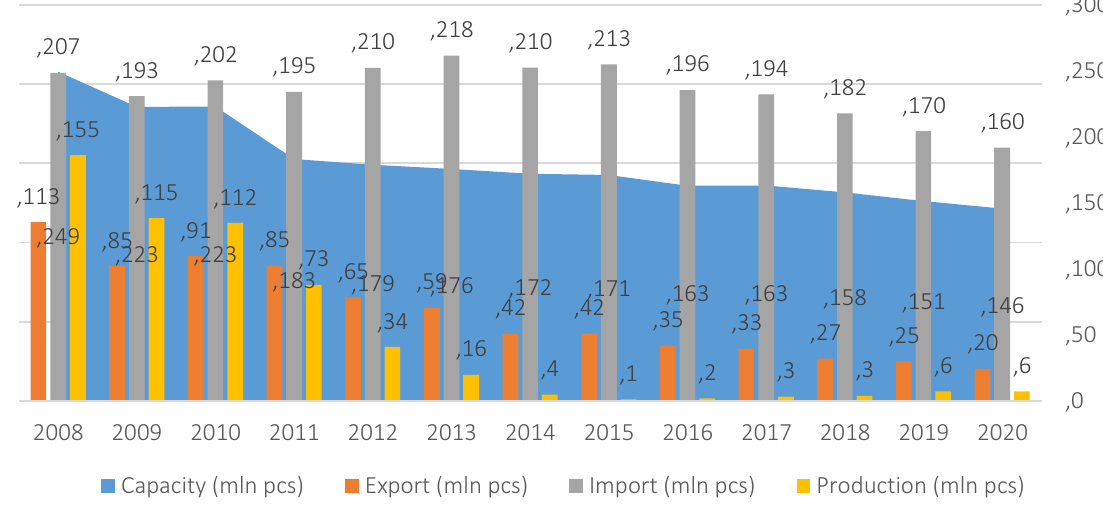
Figure 2. The structure and dynamics of the capacity of the mobile phone market in the EU (27)